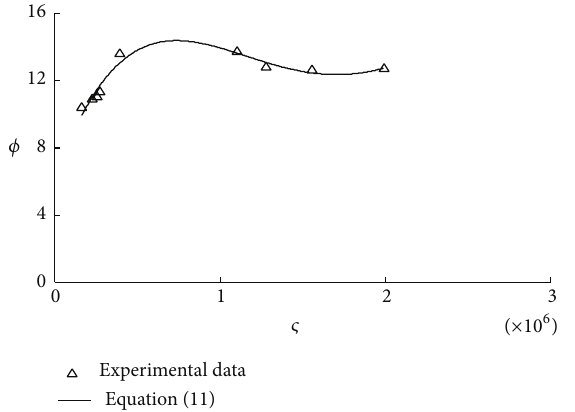
Figure 8: Change of the particles mean size growth